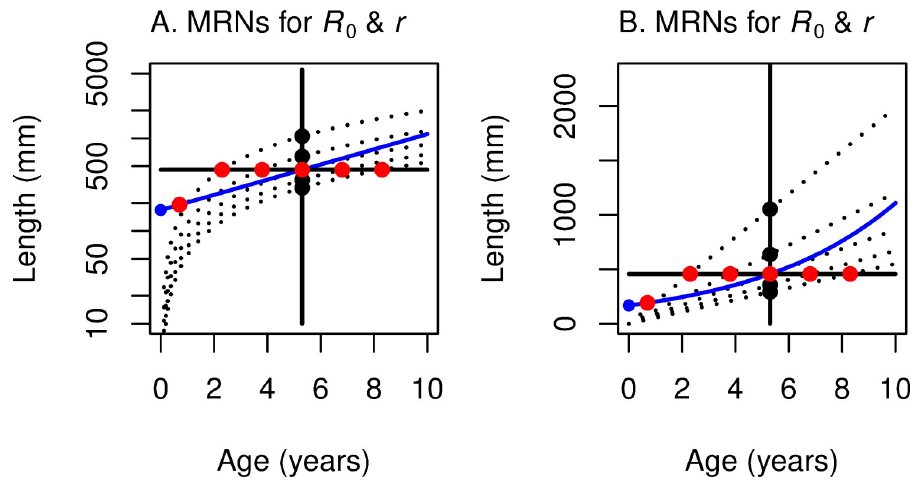
Fig 4. Growth trajectories with maturation reaction norms for maximizing r (horizontal line) and R 0 (vertical line). Growth trajectories (dotted lines) show the linear growth function L = c + k x , with c = 0; red dots show where r is maximized; black dots show where R 0 is maximized along the growth trajectory. (A) With log-length on the vertical axis, the growth trajectories are curved, and the underlying iso-fitness lines are straight lines (shown only as the blue line corresponding to R 0 = 1 or r = 0; see Fig 2A and Fig 3A). (B) With linear-length on the vertical axis, the growth trajectories are straight lines, and the underlying iso-fitness lines are curved lines (blue line corresponds to R 0 = 1 or r = 0; see Fig 2B and Fig 3B). In both panels, the MRN for fitness function r is horizontal (optimal maturation size does not change as growth rate k varies), while the MRN for fitness function R 0 is vertical (optimal maturation age does not change as growth rate k